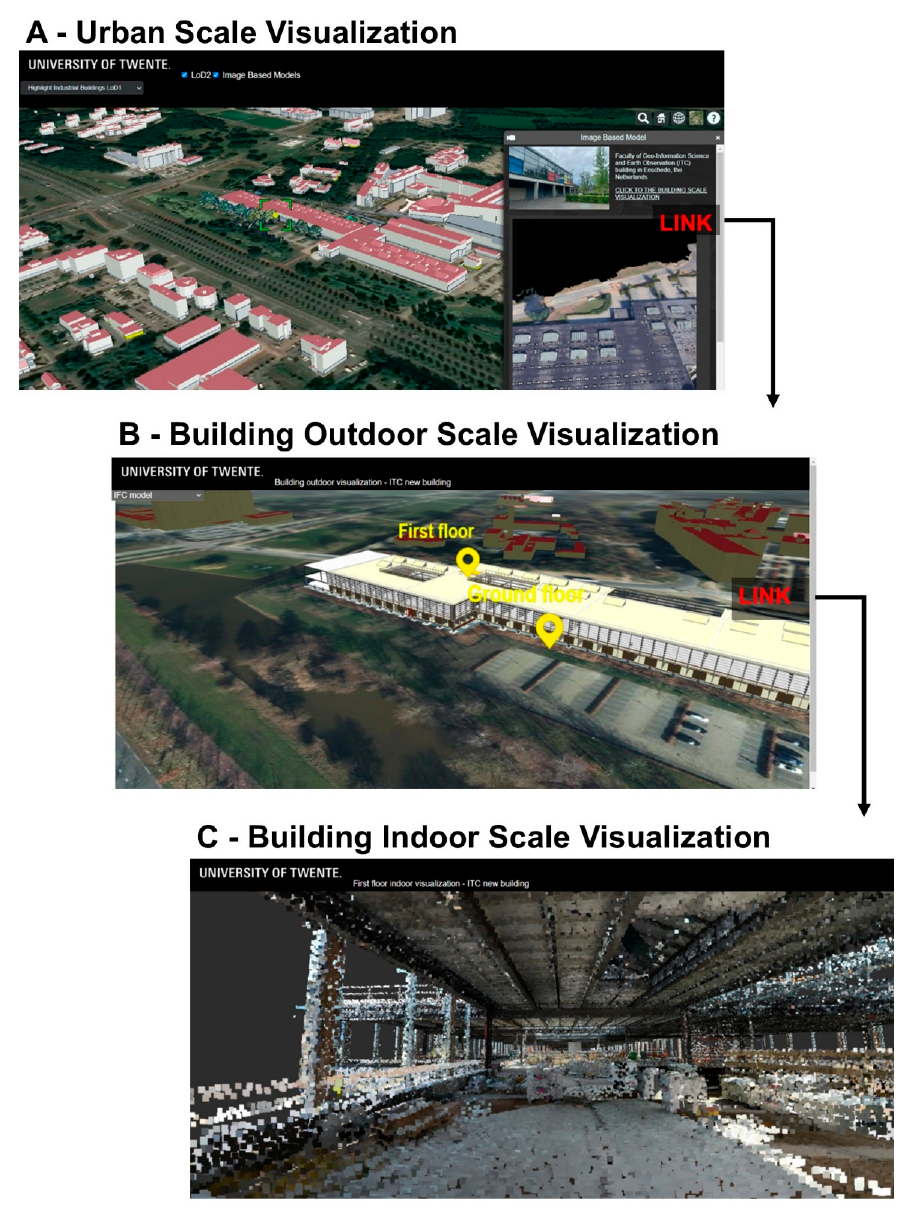
Figure 6. The connection between the different scales of visualization: ( A ) the urban-scale visualization; ( B ) the building outdoor-scale visualization; ( C ) The building indoor-scale visualization. Source: author.